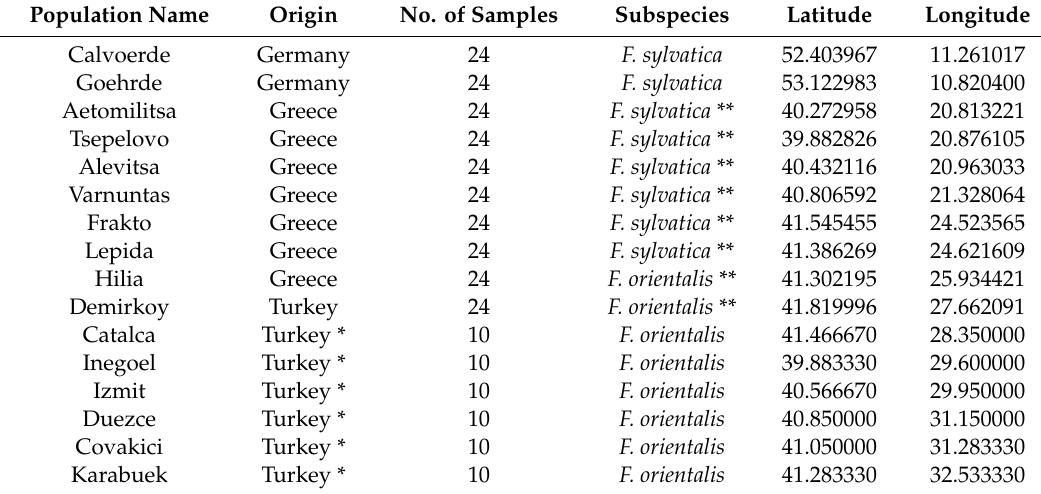
Table 1. Population